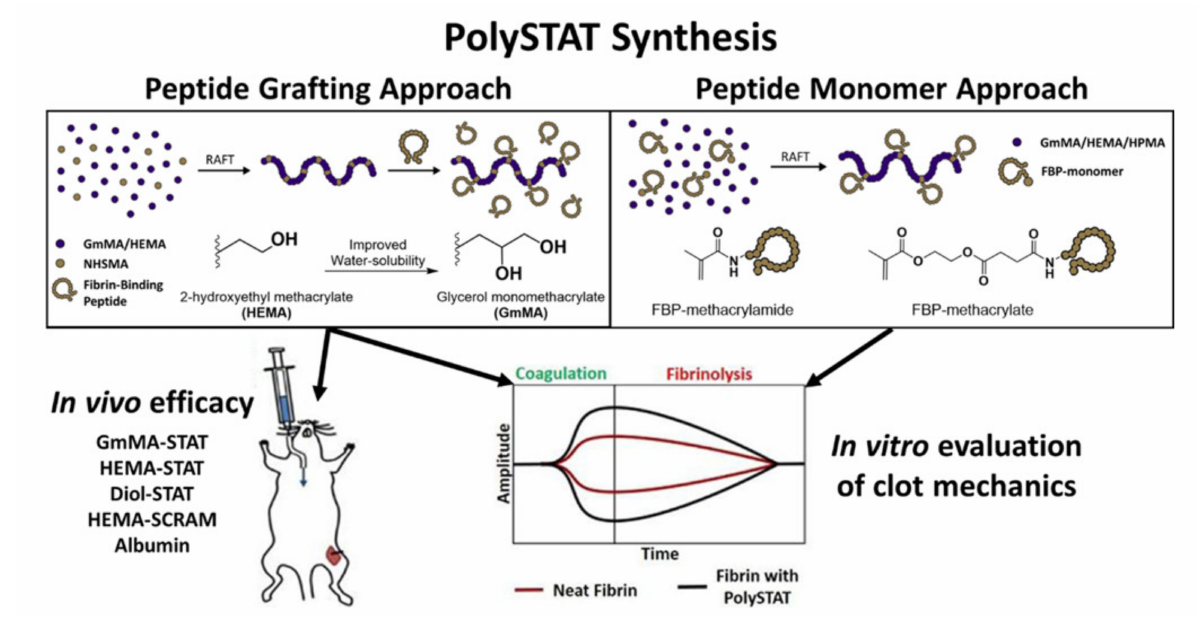
Figure 4. PolySTAT synthesis mechanism and its hemostatic performance. Adapted with permission from [134]. Copyright © 2020, American chemical